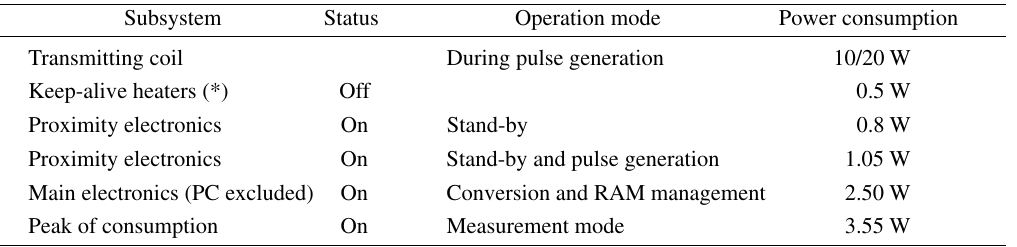
Table II. Power budget of the TDEM system designed for DEEDRI Payload.